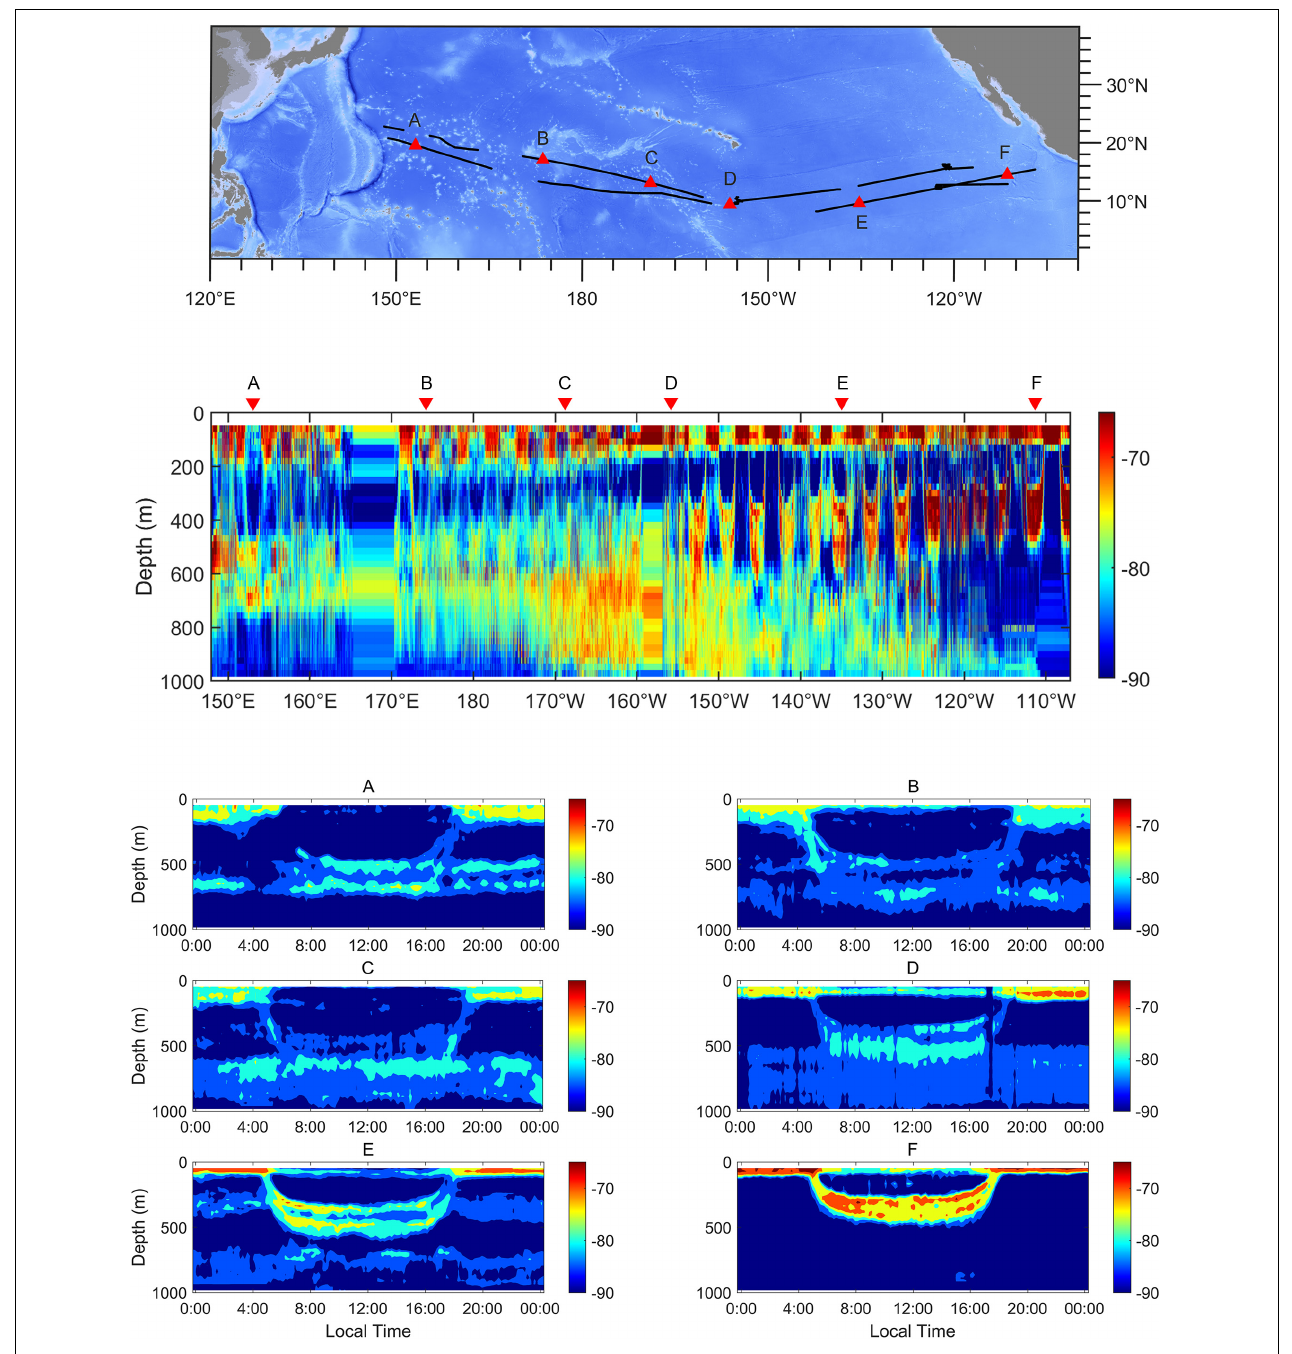
FIGURE 3 | Echograms at 38 kHz across the tropical Pacific Ocean. The positions of examples are marked as triangles in the topographic map. The echograms show the spatial variation of DSLs, SSLs, and pattern of DVM from the western to the eastern tropical Pacific Ocean (A–F) . Each echogram spans a 24-h period. The lower threshold was –90 dB. The ship-track was marked as black